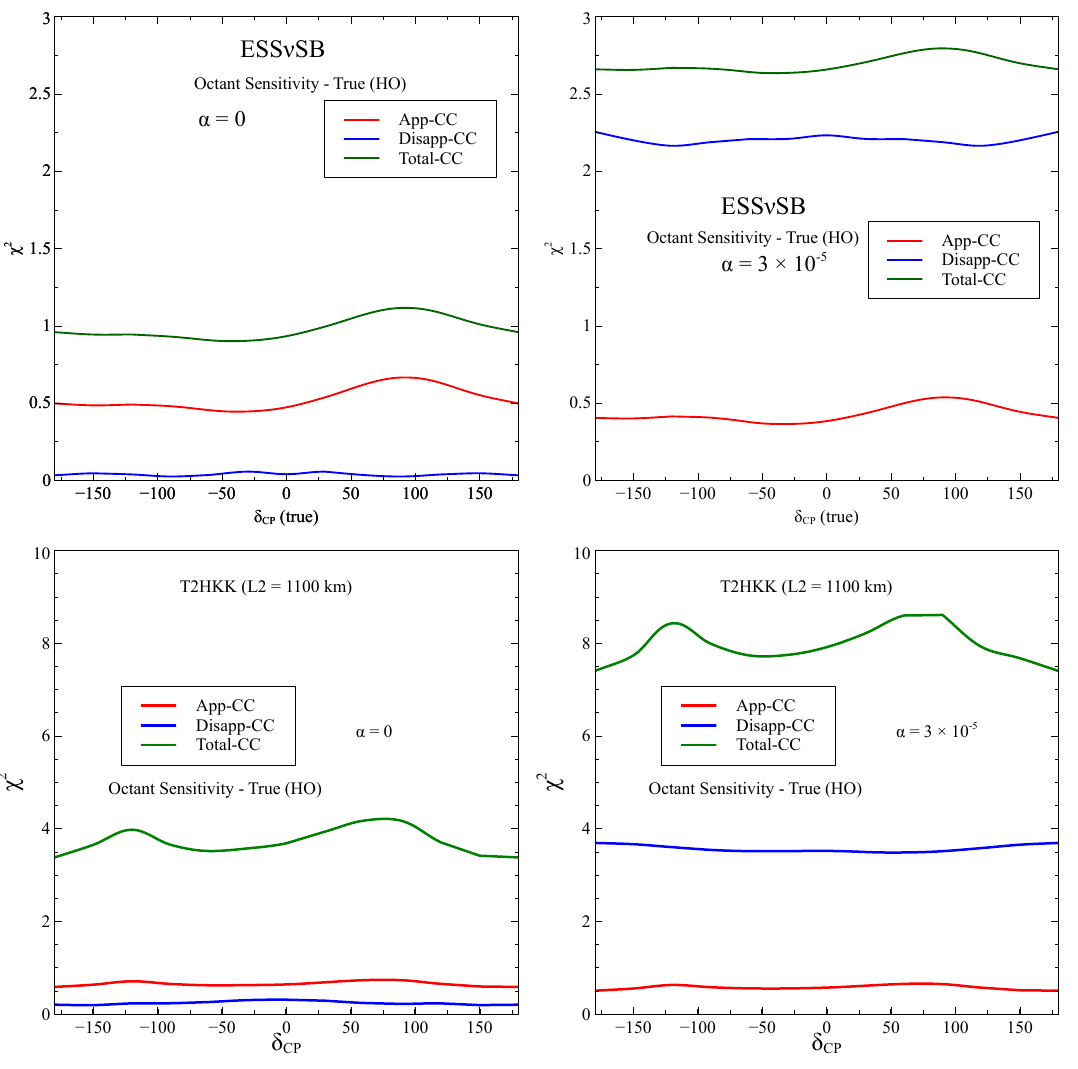
Figure 10 . The octant sensitivity χ 2 as a function of δ CP (true) for ESS ν SB(top row) and T2HKK- L2 (bottom row). The left panel represents the octant sensitivity for the case without decay i.e. α = 0 and the right panel for the case with decay α = 3 × 10 − 5 . The α values are same for both data and fit in each plot. The red and blue plots are for appearance-CC, disappearance-CC respectively, while the green plots shows the contribution from both appearance-CC and disappearance-CC. The true sin 2 θ 23 = 0 . 56 and the test θ 23 is varied in the lower octant in the range 40 ◦ < θ 23 < 45 ◦